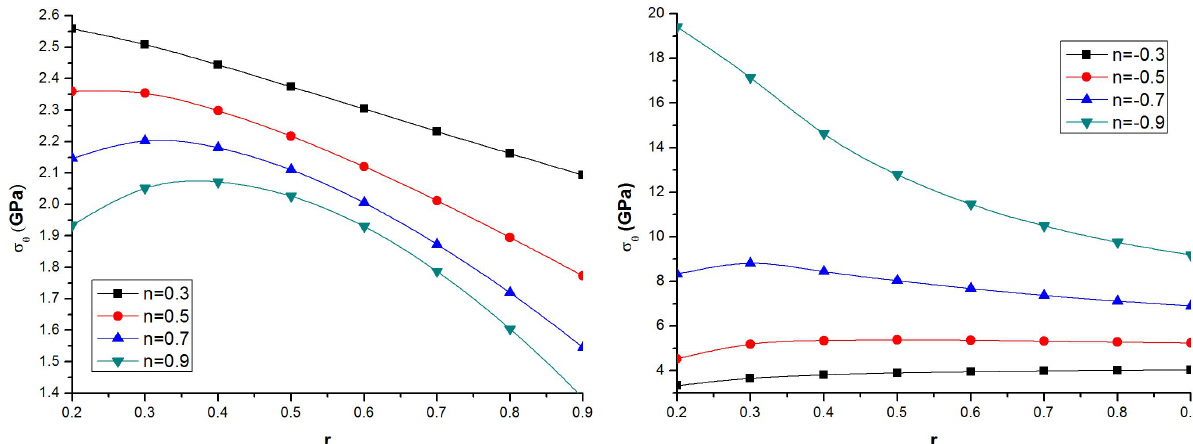
Figure 4: Variation in circumferential stress against radial coordinate for different values of n